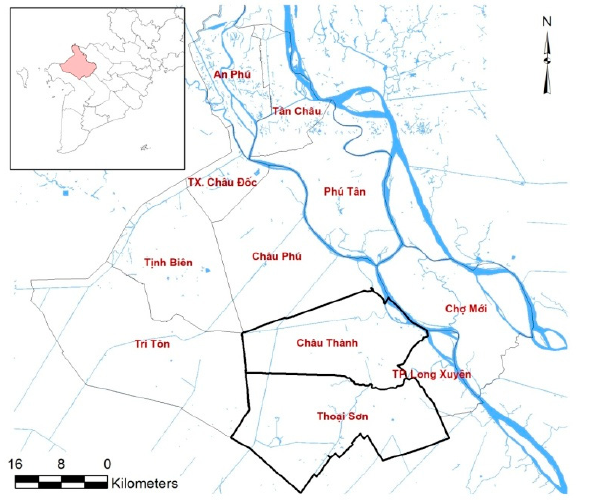
Figure 1. Location of An Giang Province and Chau Thanh, Thoai Son communes in the Mekong Delta Vietnam.